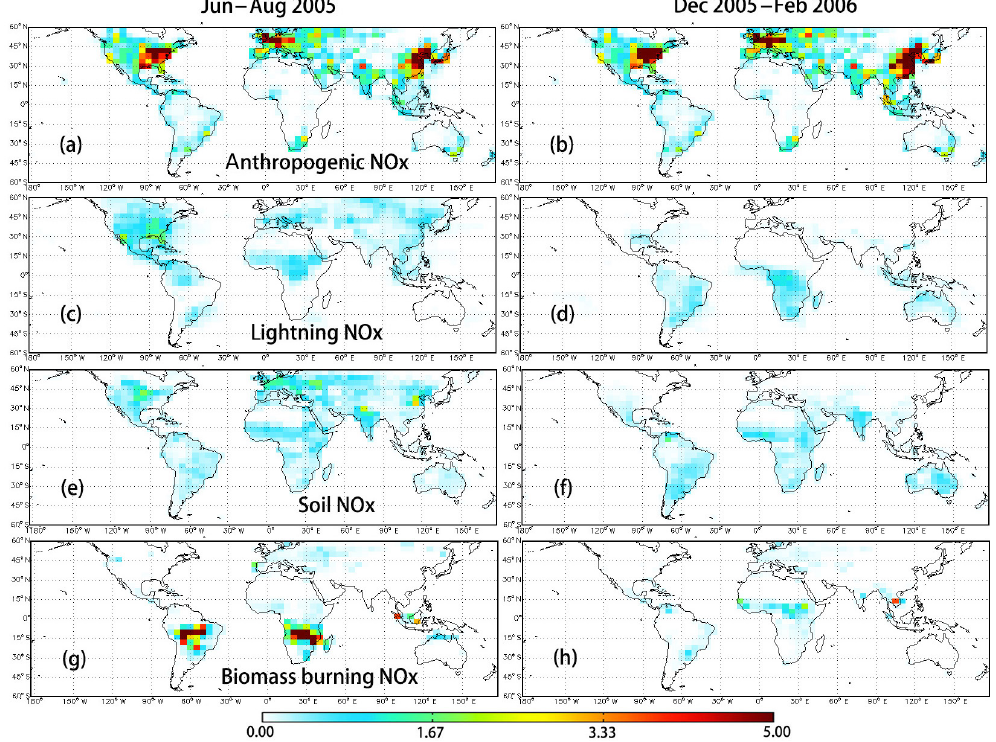
Figure 1. Seasonal mean NO x emission from anthropogenic, lightning, soil and biomass burning. The unit is 10 10 moleccm − 2 s − 1